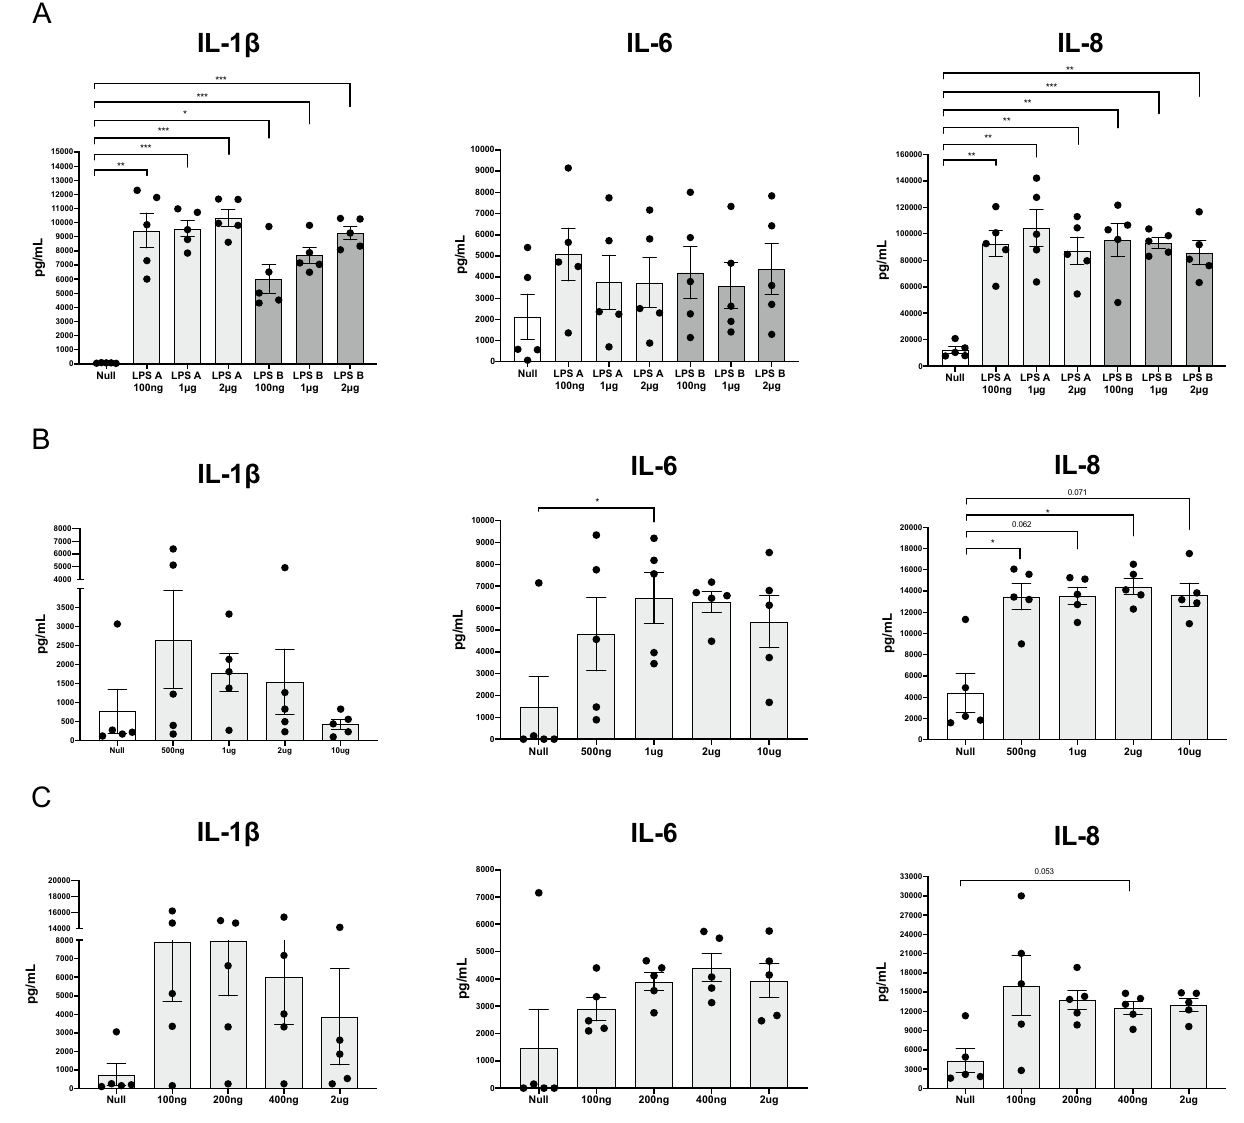
Figure 1. Dose responses of bacterial and viral PAMP using IChek. Dose responses of five animals stimulated for 24 hr with ( A ) 0.1–2 µg/mL of LPS serotype A and B; ( B ) 0.5-10 µg/mL of Pam3CSK4 and ( C ) 0.1–2 µg/mL of R848 or null, using 1 mL of whole blood collected for each stimulation. Protein expression of IL-1β, IL-8 and IL-6 was measured in the supernatant of each stimulation using ELISA, reported as pg per 1 mL of blood, and were used as immune response readouts. Statistical significance was calculated using repeated measures one- way ANOVA with Dunnett’s multiple comparisons between null and induced